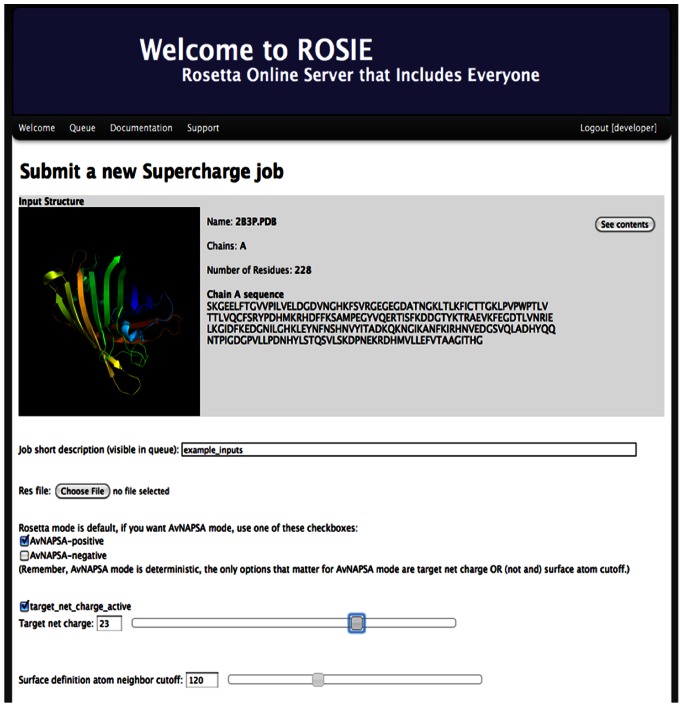
User interface for running the supercharge protocol on the ROSIE web server.The user uploads a PDB, then uses checkboxes or sliding bars to specify the protocol options, not all options are shown here (Table 1). Job status and protocol documentation can be viewed in the Queue and Documentation tabs.